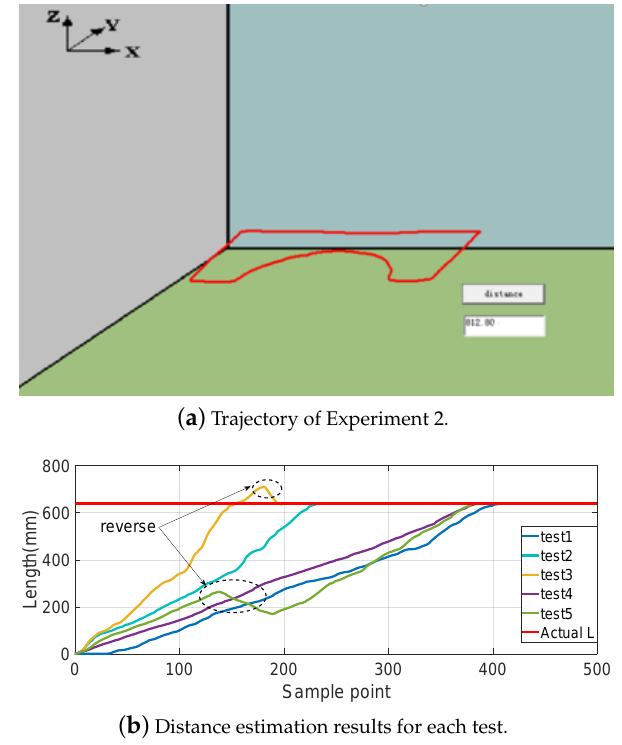
( b ) Distance estimation results for each test. Figure 9. Experiment 2: consisting of straight lines and a semicircular arc; path length is 638